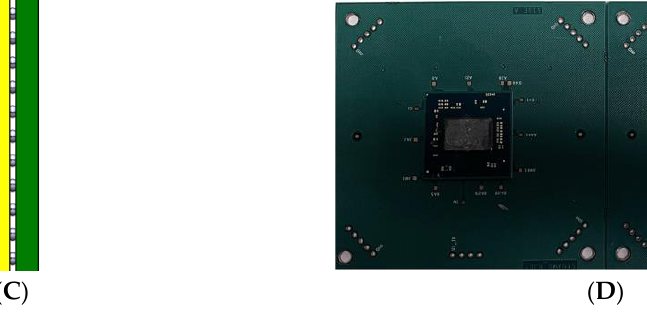
Figure 1. Test vehicle with different user PCB thicknesses ( A ): 1.6-mm board, ( B ): 1-mm board, ( C ): solder detail, ( D ) photograph of the test vehicle.